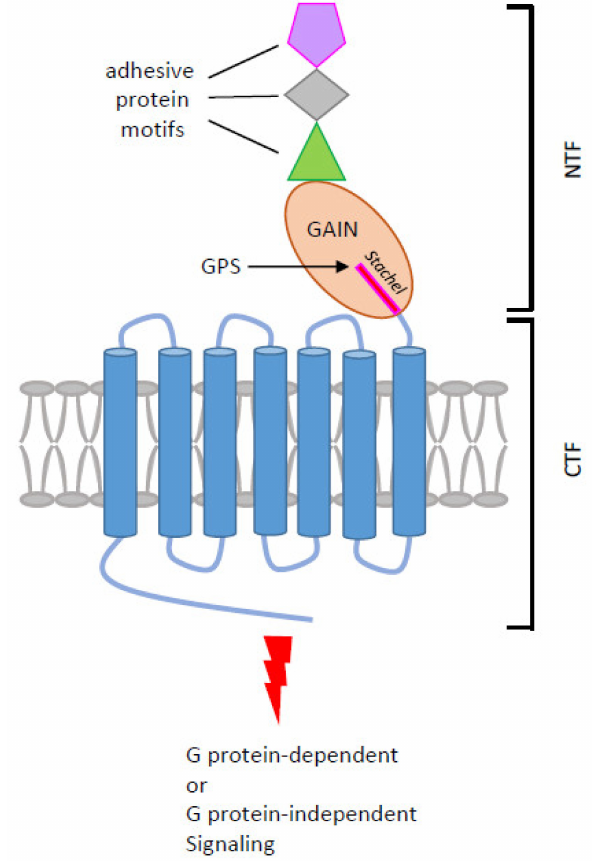
Figure 1. Structural and signaling characteristics of aGPCRs. The diagram shown is the schematic representation of aGPCR in general. The N-terminal fragment (NTF) contains various cell-adhesive protein motifs (colored shapes) followed by a GAIN domain in which an autoproteolytic reaction occurs at the consensus GPS motif. GPS autoproteolysis cleaves the receptor into the NTF and the C-terminal fragment (CTF) with a new N-terminal sequence (Stachel peptide). Upon ligand binding and/or mechanical stimulation, the NTF is dissociated/dislocated from the CTF to allow the Stachel peptide to bind to the 7TM region, inducing conformational changes and G protein-dependent or -independent